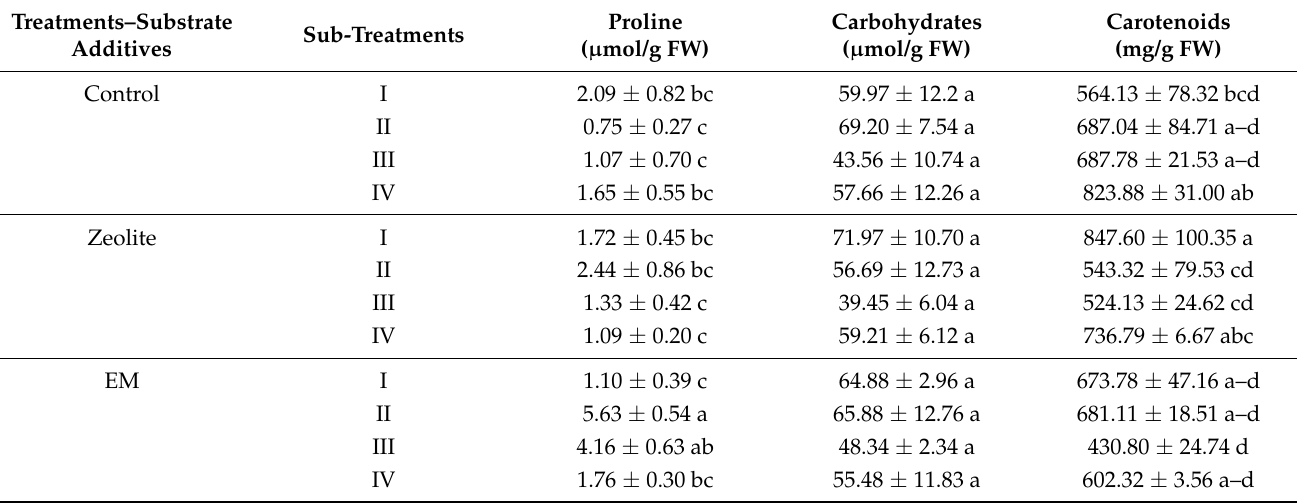
Table 2. Proline, carbohydrate, and carotenoid concentration in leaves of the apple